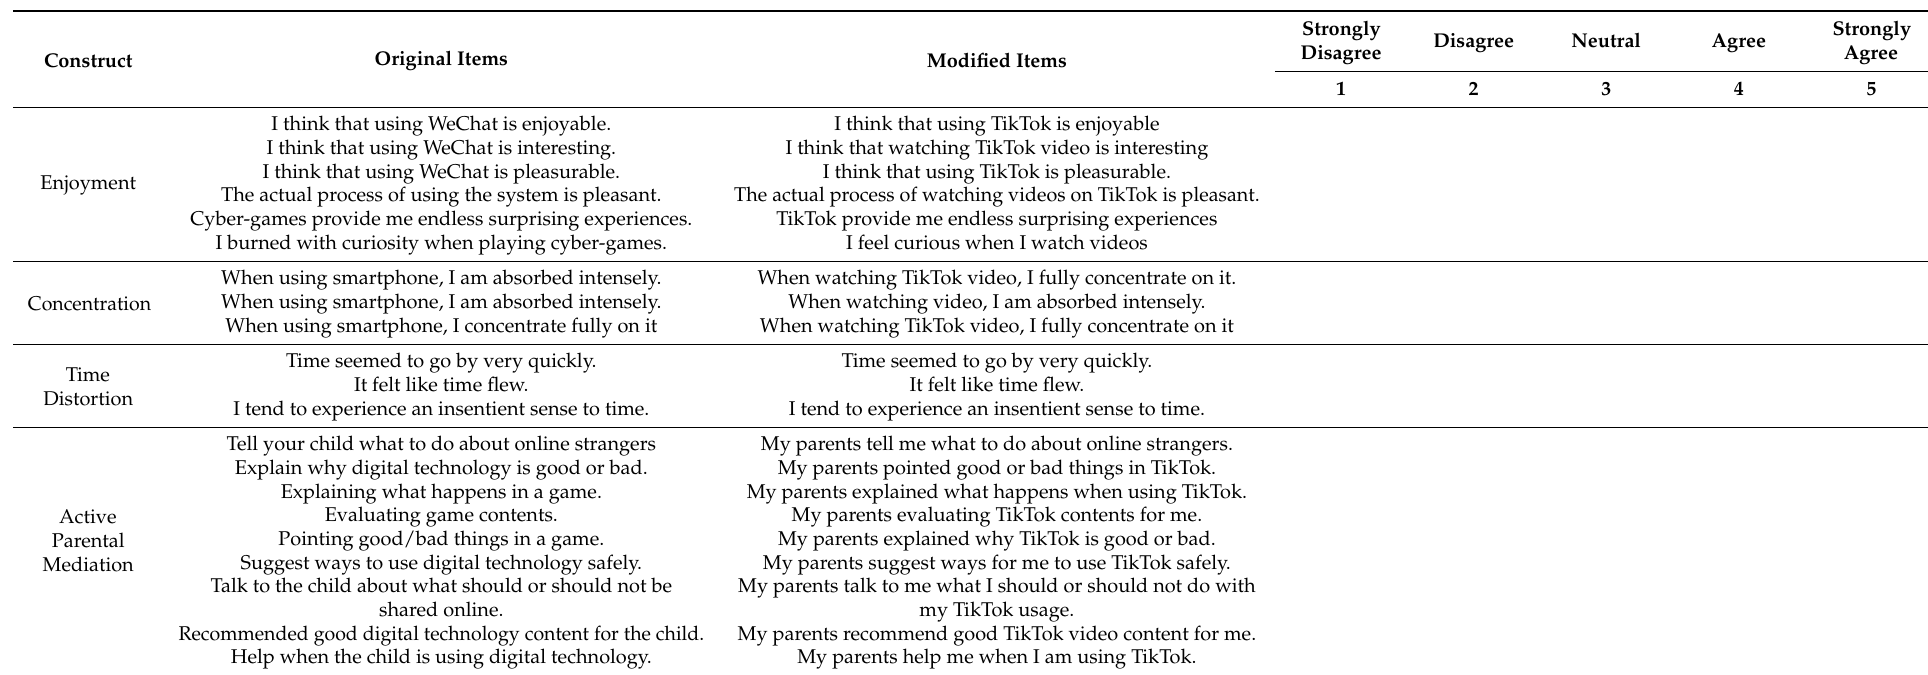
Table A1. Measurement Items of Each